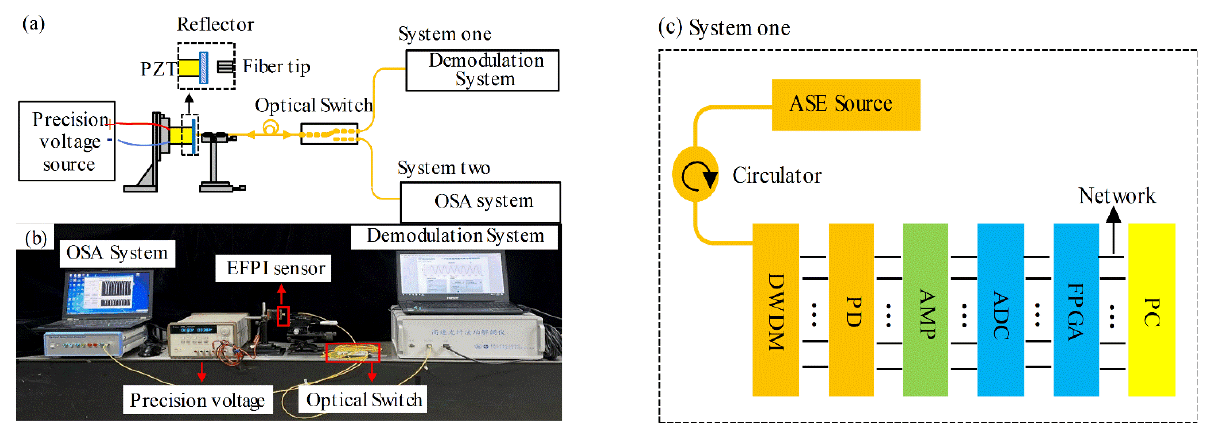
Figure 9. ( a ) Schematic of experimental measurement system, ( b ) photograph of the experimental measurement system and ( c ) schematic of system one (the proposed system) (PZT: piezoelectric transducer; ASE: amplified spontaneous emission; DWDM: dense wavelength division multiplexing; PD: photodetector; AMP: amplifier; ADC: analog-to-digital converter; FPGA: field programmable gate array (Xilinx Spartan-6, XC6SLX45-2FGG4841); PC: personal computer (processor: Intel (R) Core (TM) i5-8400; CPU: 2.8 GHz; RAM: 8 GB)).